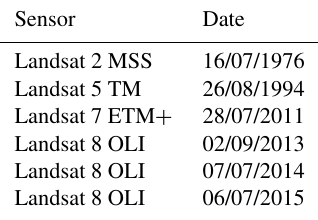
Table 1. Sensors (MSS: Multispectral Scanner System; TM: The- matic Mapper; ETM + : Enhanced Thematic Mapper Plus; OLI: Op- erational Land Imager) and acquisition dates of the Landsat imagery used for the mapping of the glacier